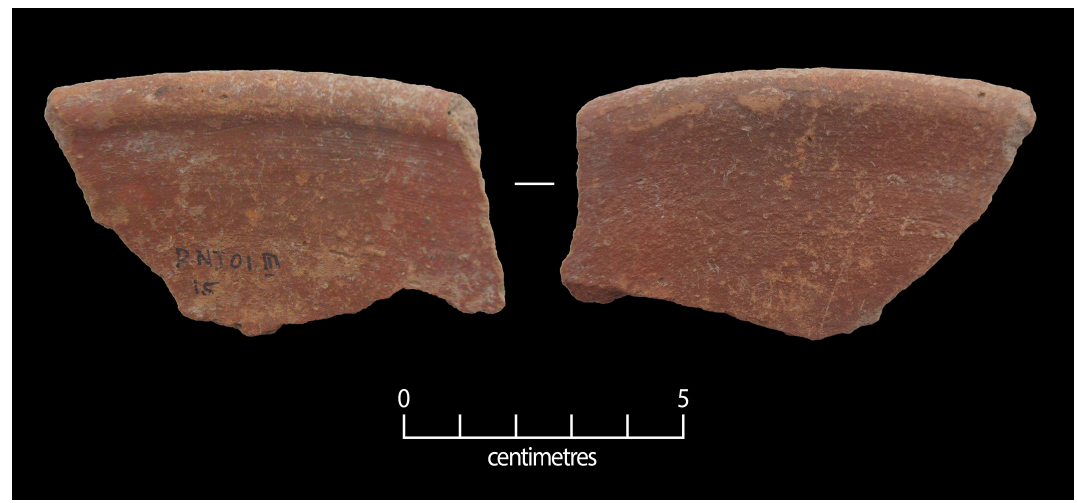
Figure 16: External and internal surfaces of Class 5 variant 2